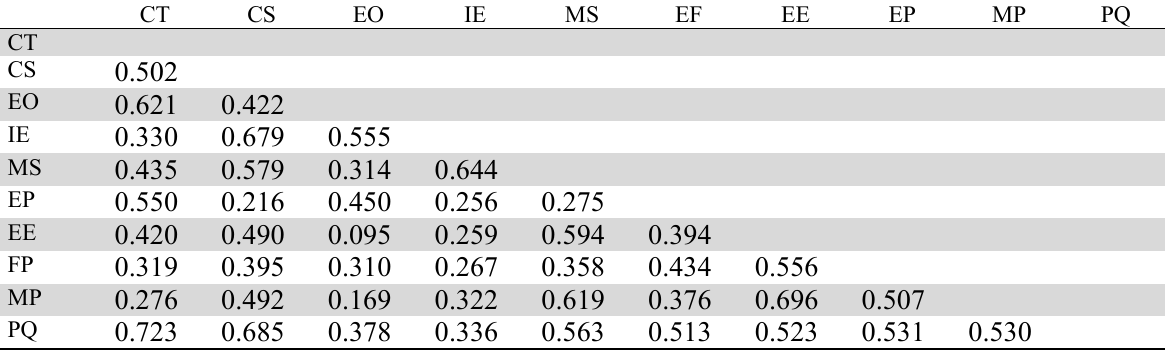
Analysis of Heterotrait-Monotrait Ratio of Correlations